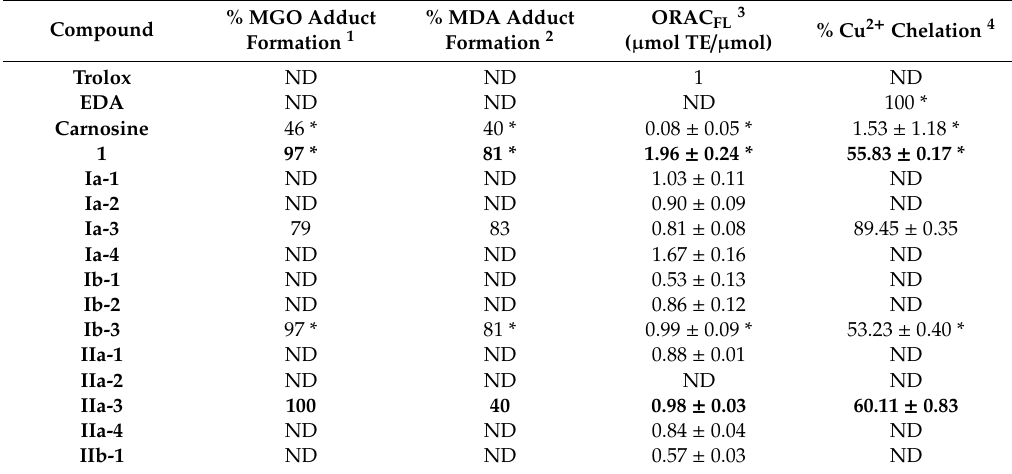
1 Data obtained in 15 min of incubation at 37 ◦ C for a representative single sample. 2 Data obtained in 1 h of incubation at 37 ◦ C for a representative single sample. 3 ORAC FL values are expressed as means ± standard error of the mean (SEM) of three independent experiments performed in triplicate and calculated at 10 µ M. 4 % Cu 2 + chelation are expressed as means ± SEM of triplicates and measured at 200 µ M. * Previously reported data [8]; TE: Trolox equivalent; ND: Not determined.